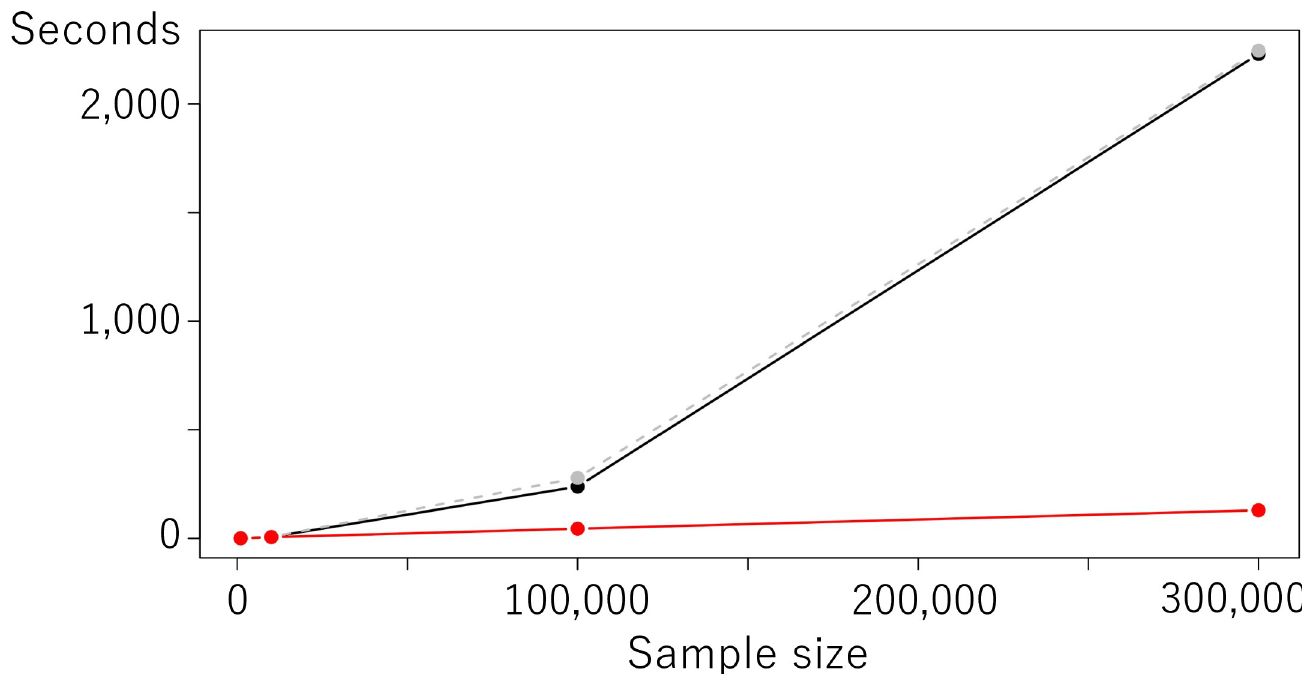
Fig 12. Computation time comparison under case 2 (model with spatial